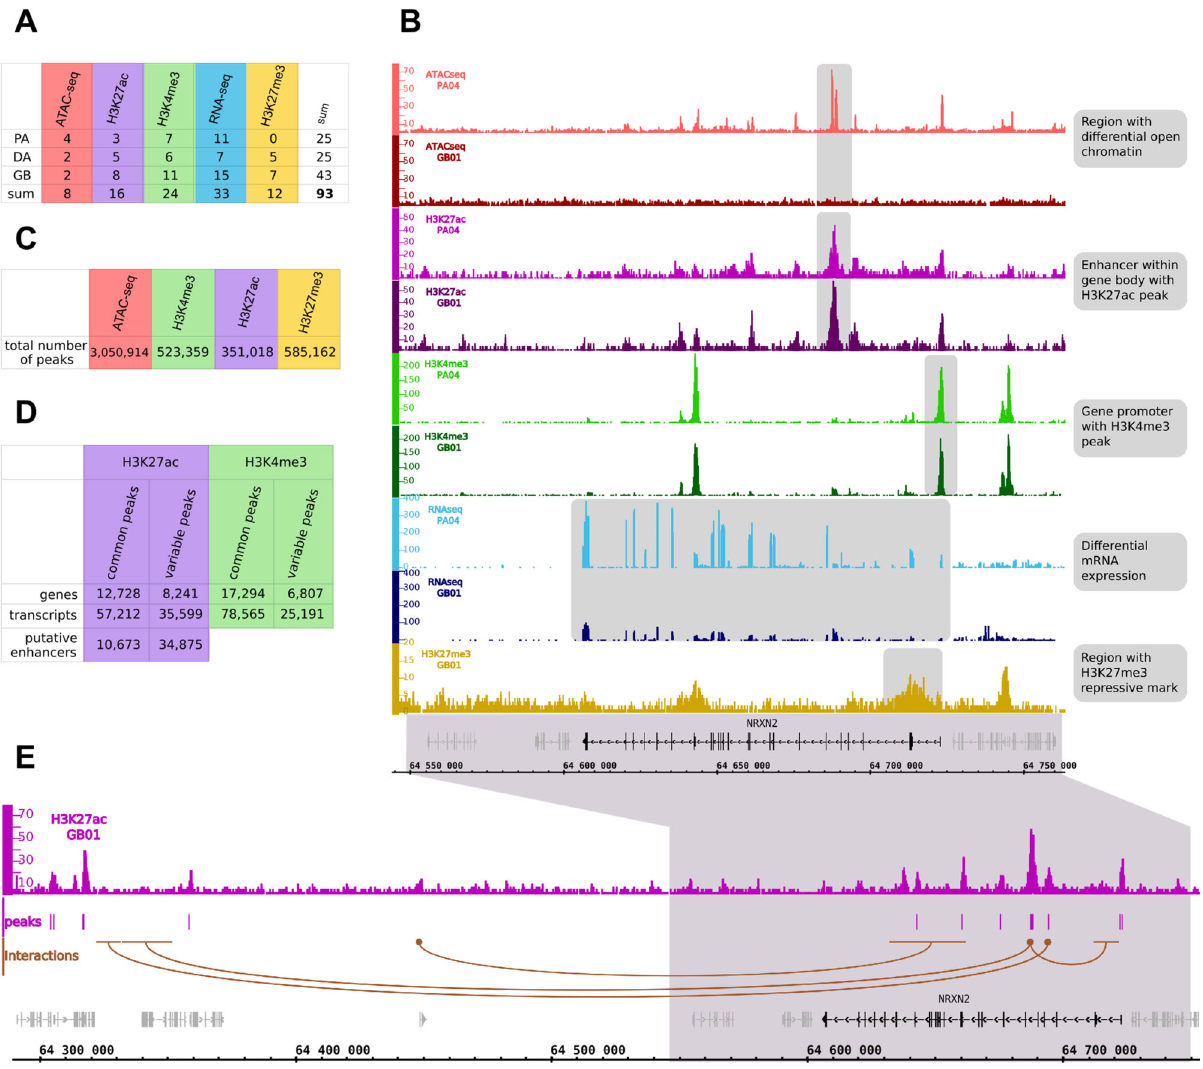
Fig. 2 Construction of an atlas of regulatory sites in gliomas. A Numbers of samples from gliomas of different grades for which ATAC-seq, ChIP-seq, and RNA-seq data were collected. B Representative peaks of ATAC-seq, ChIP-seq, RNA-seq at the NRXN2 gene in pilocytic astocytomas (PA04) and glioblastoma (GB01) samples. Note high expression of the NRXN2 in PA in comparison to GB, which correlates with the lack of the ATAC-seq signal in GB (shadowed blocks). C Total numbers of peaks identi fi ed in all samples across performed experiments. D Numbers of identi fi ed common and variable active regulatory elements, genes and transcripts. E Example of promoter-enhancer interactions identi fi ed using Hi-C data (Won et al., 2016). Brown dots represent “ anchors ” , while brown horizontal lines depict predicted interaction